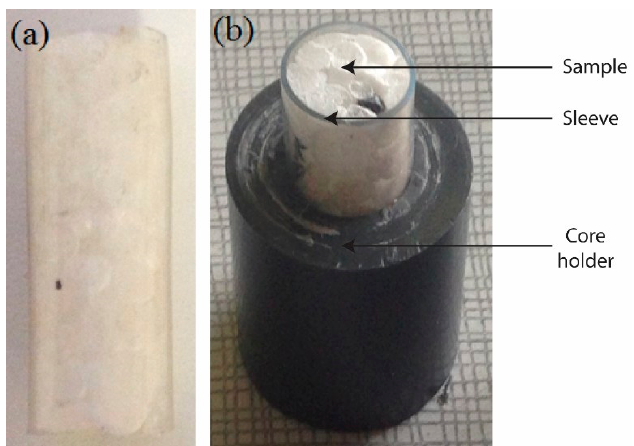
Figure 1. ( a ) Uncompressed sample with polytetrafluoroethylene (PTFE) sleeve; and ( b ) bottom part of the core holder (the top part is exactly the same as the bottom one and both parts are glued with epoxy glue).